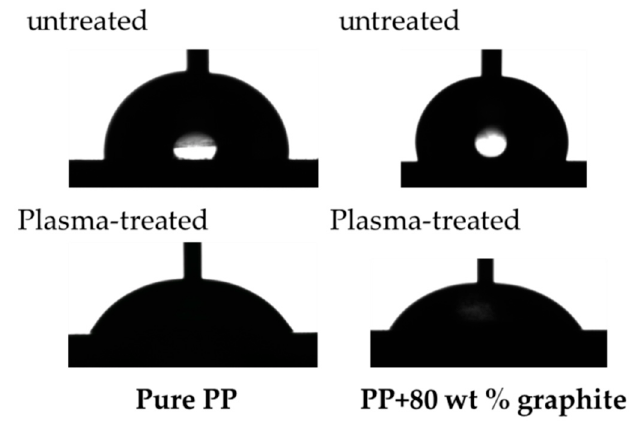
Figure 4. Water contact angle on untreated and plasma-treated surfaces of pure PP ( left ) and PP/80 ( right ).